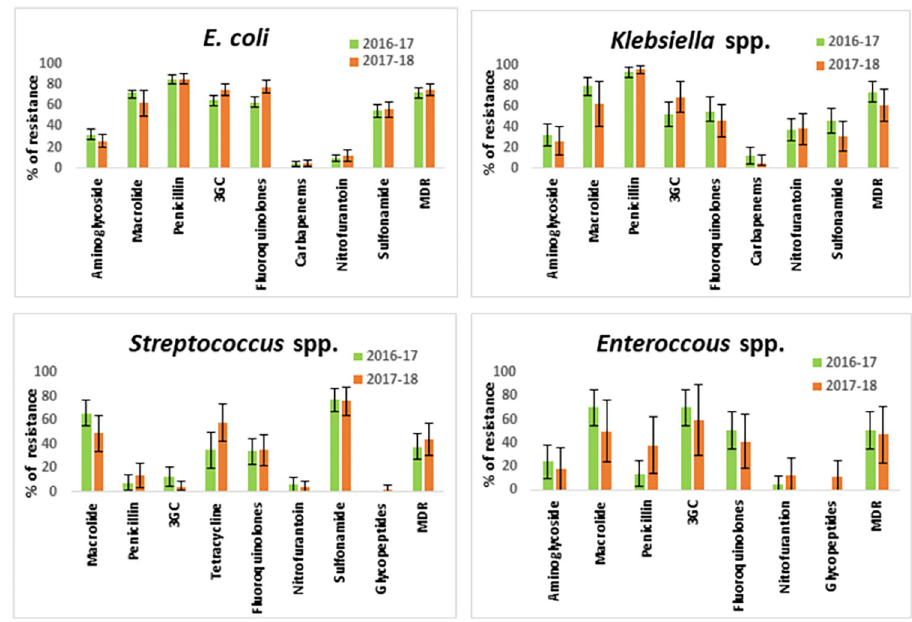
Fig 2. Antibiotic resistance profiles of four major pathogens causing community-acquired UTI from 2016 to 2018. Only those antibiotics were included in the analysis for which the minimum number of isolates tested was 10.